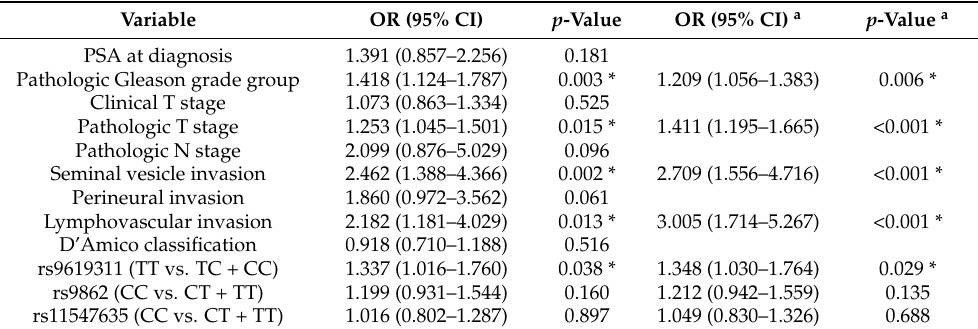
Table 3. The multivariate analysis for biochemical recurrence in 579 patients with prostate